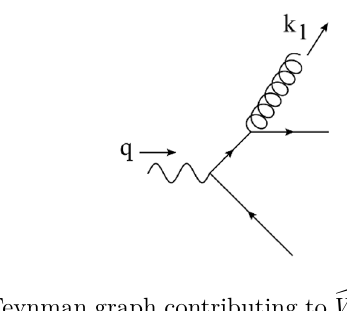
Figure 1 . The only 1-loop Feynman graph contributing to c W µν quark. The emission from the antiquark line is